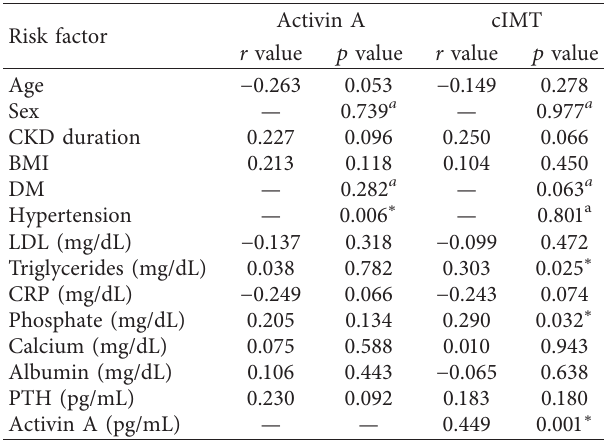
Table 2: Association of risk factors and the activin A serum level with cIMT.